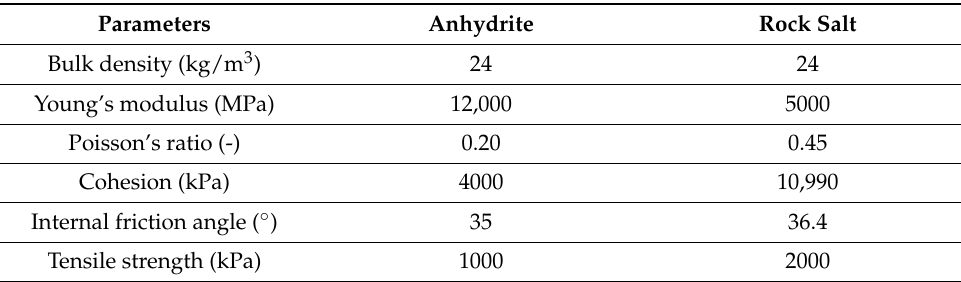
Table 2. Mechanical parameters applied in the geomechanical analysis.